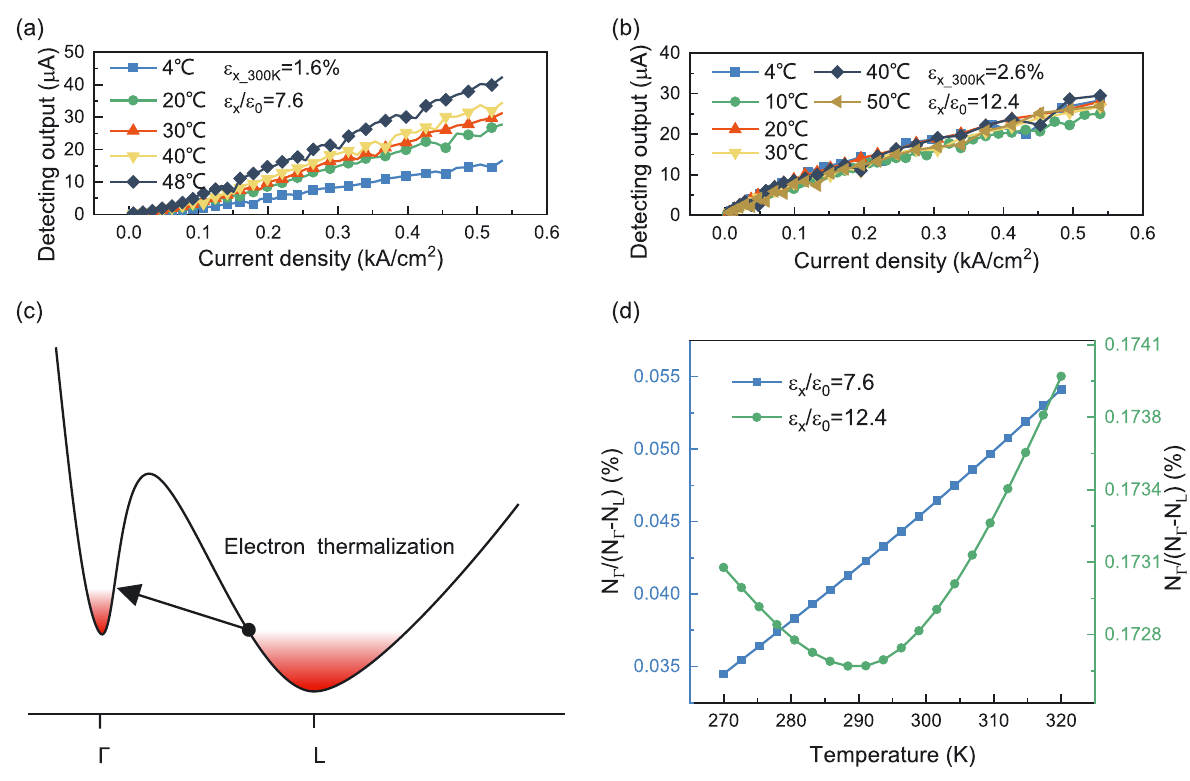
Figure 9: Comparisonof thedetectingoutputvariationtendencywith changingtemperature fordifferent strainvaluesandthecorresponding analysis. (a)Detectingoutputforamicrobridgeof ε x / ε 0 =7.6atdifferenttemperatures.(b)Detectingoutputforamicrobridgeof ε x / ε 0 =12.4atdifferent